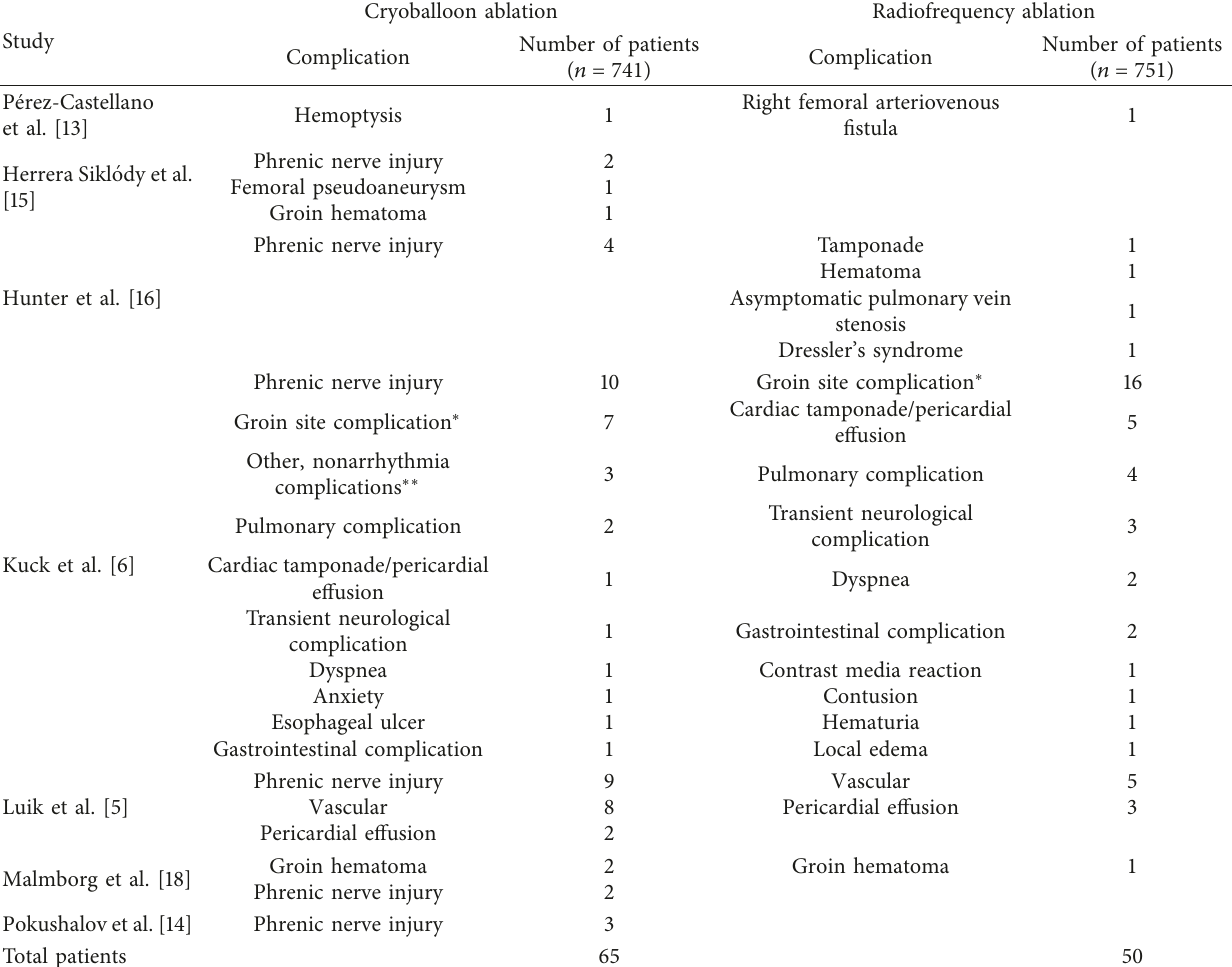
Table 3: Reported postoperative complications after cryoballoon ablation versus radiofrequency ablation.